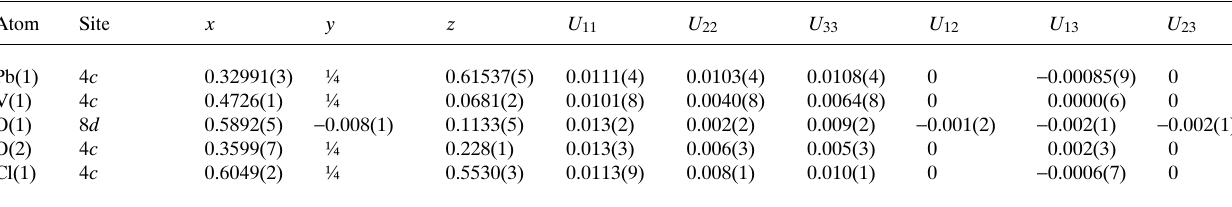
Table 2. Atomic coordinates and displacement parameters (in Å 2 )